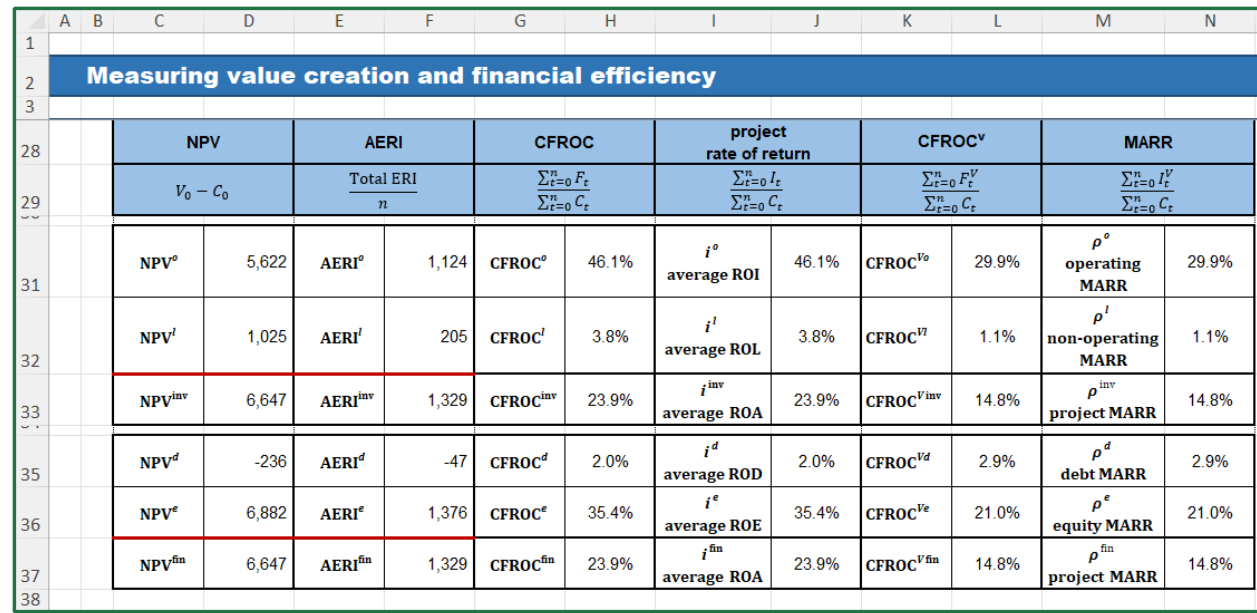
Figure 58. Measures of economic profitability (“ValueCreation” sheet).